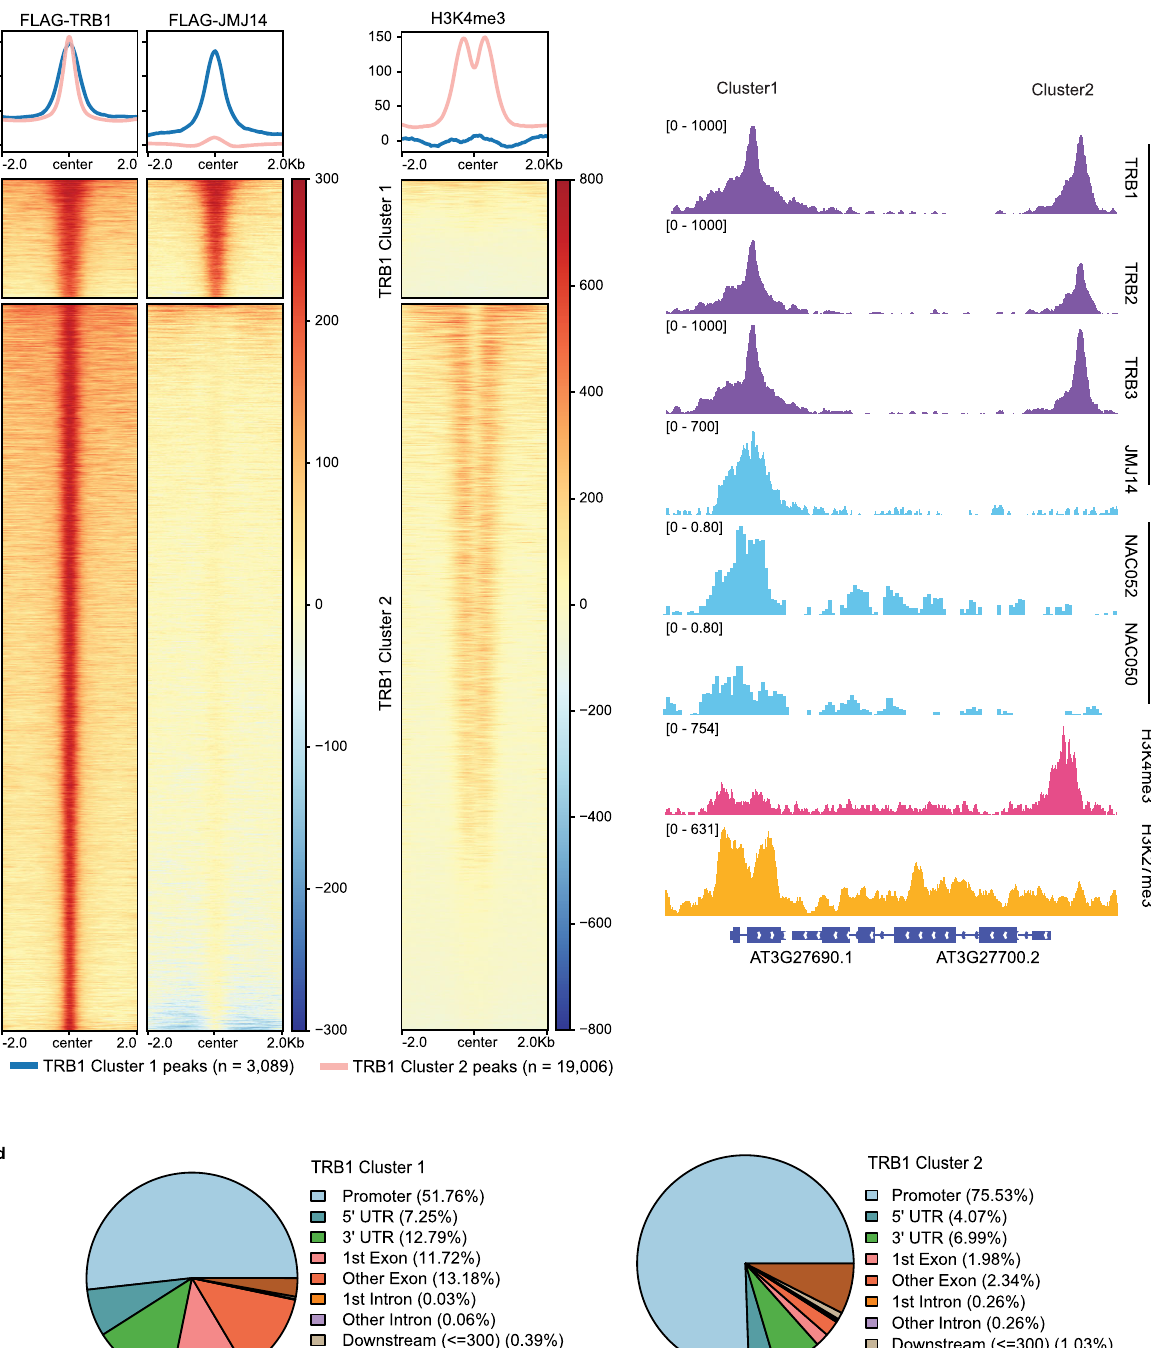
seq signals of FLAG-TRB1, FLAG-TRB2, FLAG-TRB3, FLAG-JMJ14, HA-NAC052, HA- NAC050, H3K4me3, and H3K27me3 over a representative locus containing TRB1 Cluster 1 and Cluster 2 peaks. d Pie Charts depicting the annotations of the TRB1 Cluster 1 peaks (left panel) and Cluster 2 peaks (right